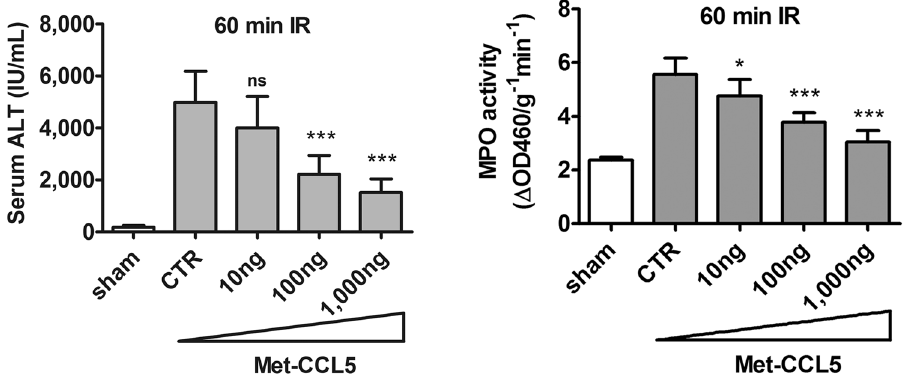
Figure 2. Inhibition of inflammatory hepatic IR injury by Met-CCL5. C57BL/6C mice were subjected to ischemia for 60 minutes and received escalating doses of Met-CCL5 (0, 10, 100 and 1,000 ng) via jugular vein immediately after reperfusion. Mice were sacrificed at 24 hours after reperfusion. Both the serum ALT and tissue MPO activities decreased significantly in a dose dependent manner (Mean ± SD, n = 10, ischemic time = 60 min). CTR, control. ns = not significant at p > 0.05; * p < 0.05; ** p < 0.01, *** p < 0.0001.